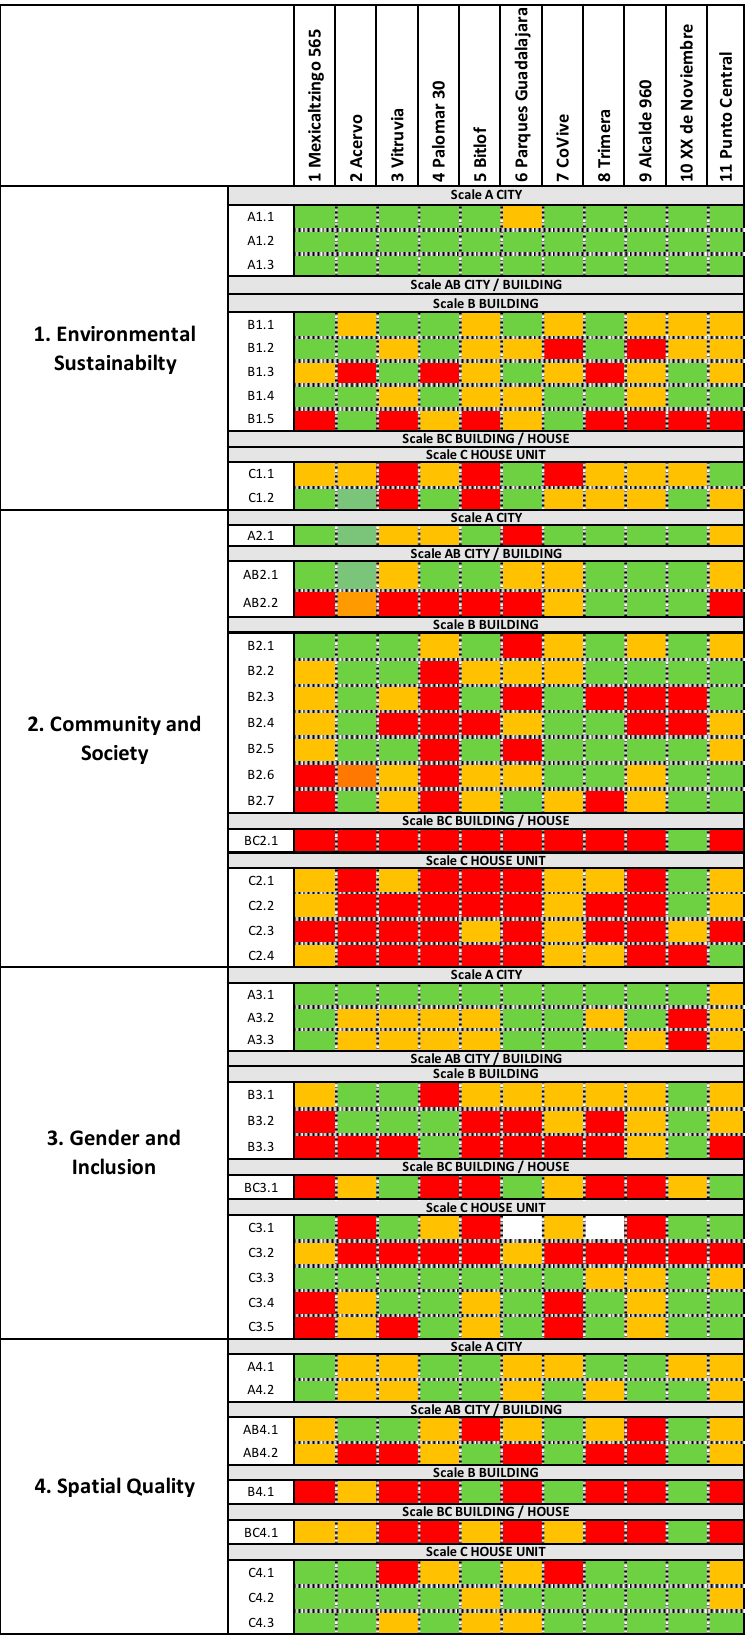
Figure 8. Study cases analysis matrix where the green color indicates that the indicator is met, the red color that it is not met and the orange that it is only partially met. Source own elaboration.